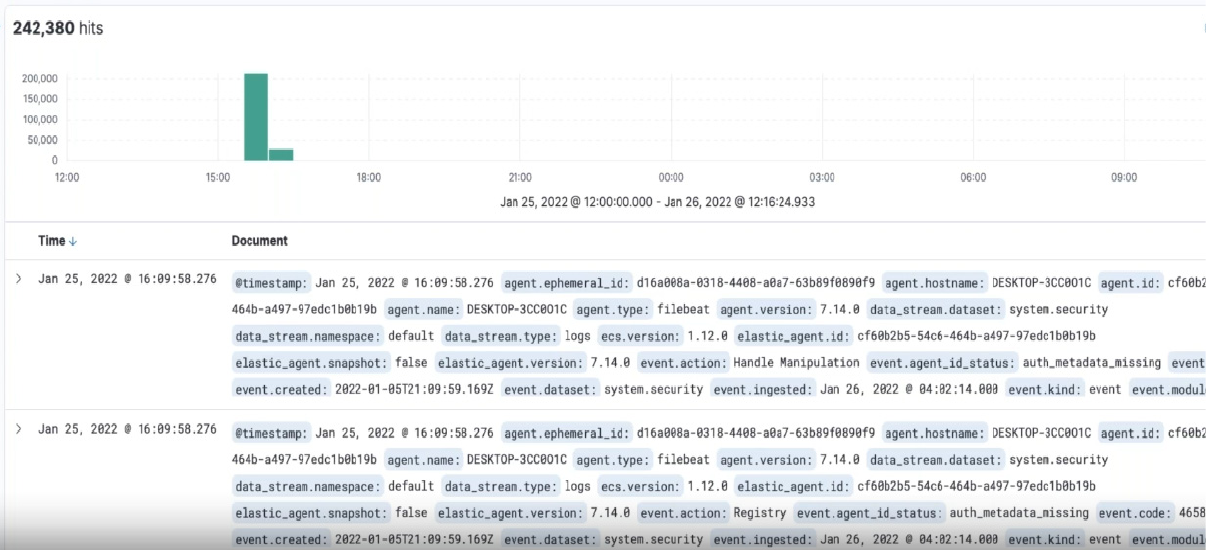
Figure 4. Threat hunt search. The platform provides details of real-world attack executions related to ‘Microsoft Office’ and Excel documents to Elastic and so the focus is on the Endpoint Sysmon cate- gory as presented in Figure 5 which provides the actual script to query the Elastic Instance having the attack logs.